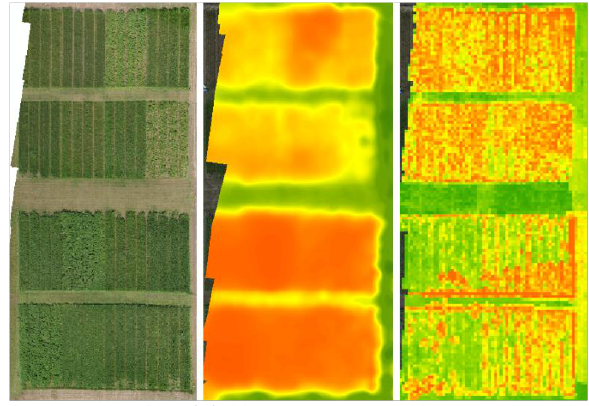
Figure 5. Results of fodder experiment in the second epoch. Orthophoto (left), difference method (center) and 3D point cloud method (right).